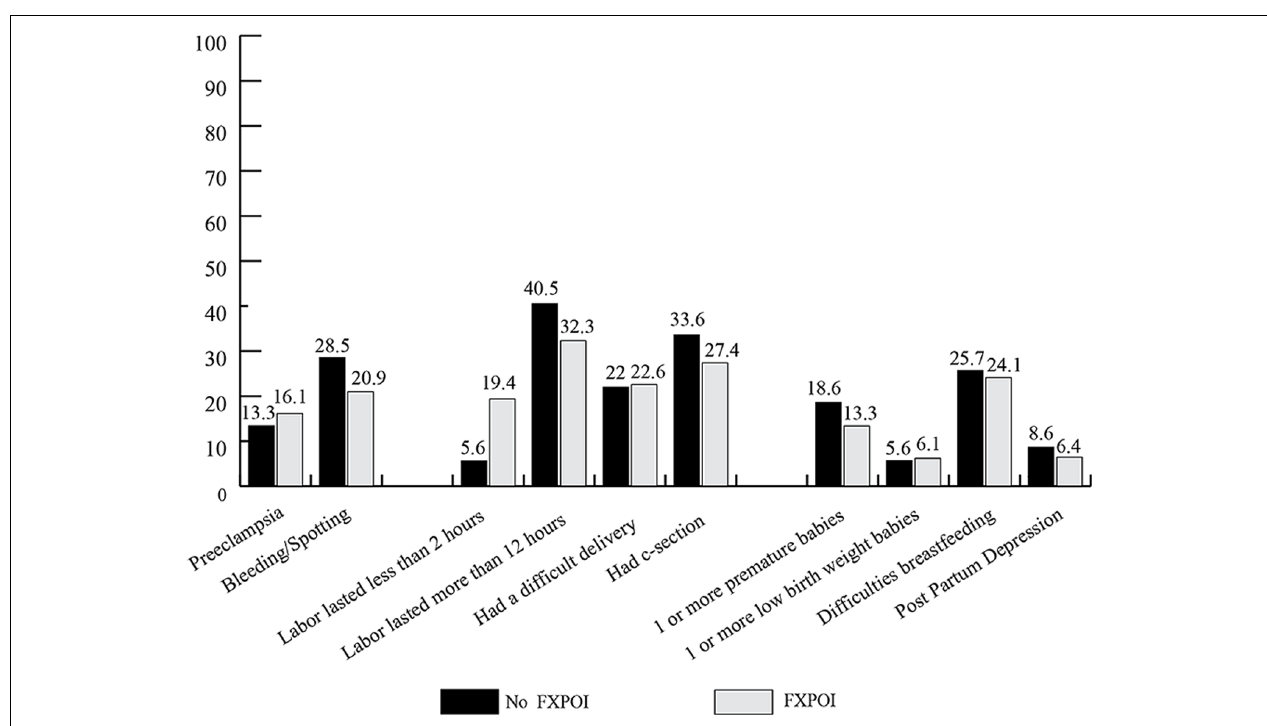
FIGURE 10 | Percentage of women experiencing pre-, peri-, or postpartum